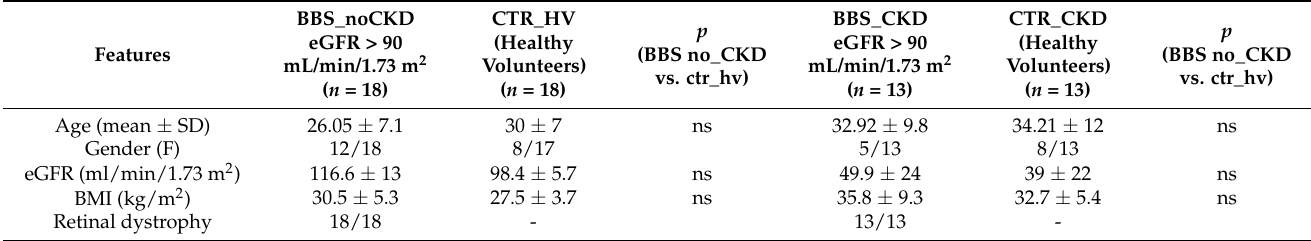
Table 4. Major features of BBS patients and controls: The Confirmation study